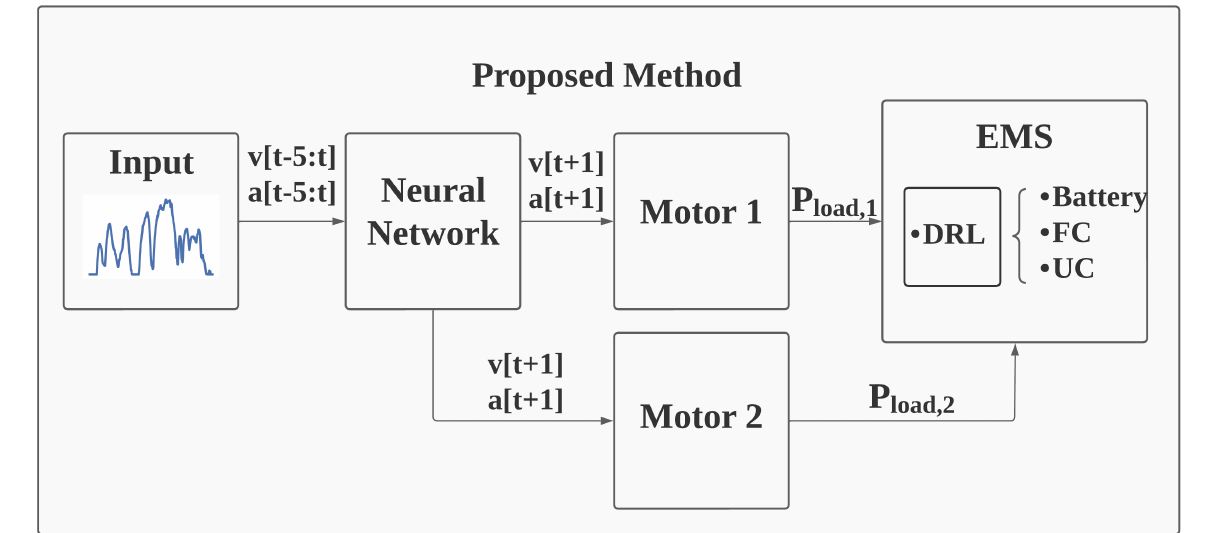
Figure 1. Procedure of reinforcement learning-based EMS.